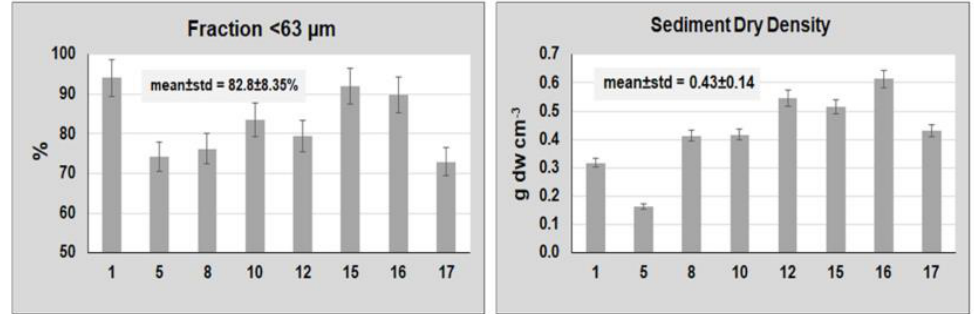
< 63 µ m) and dry density of surface